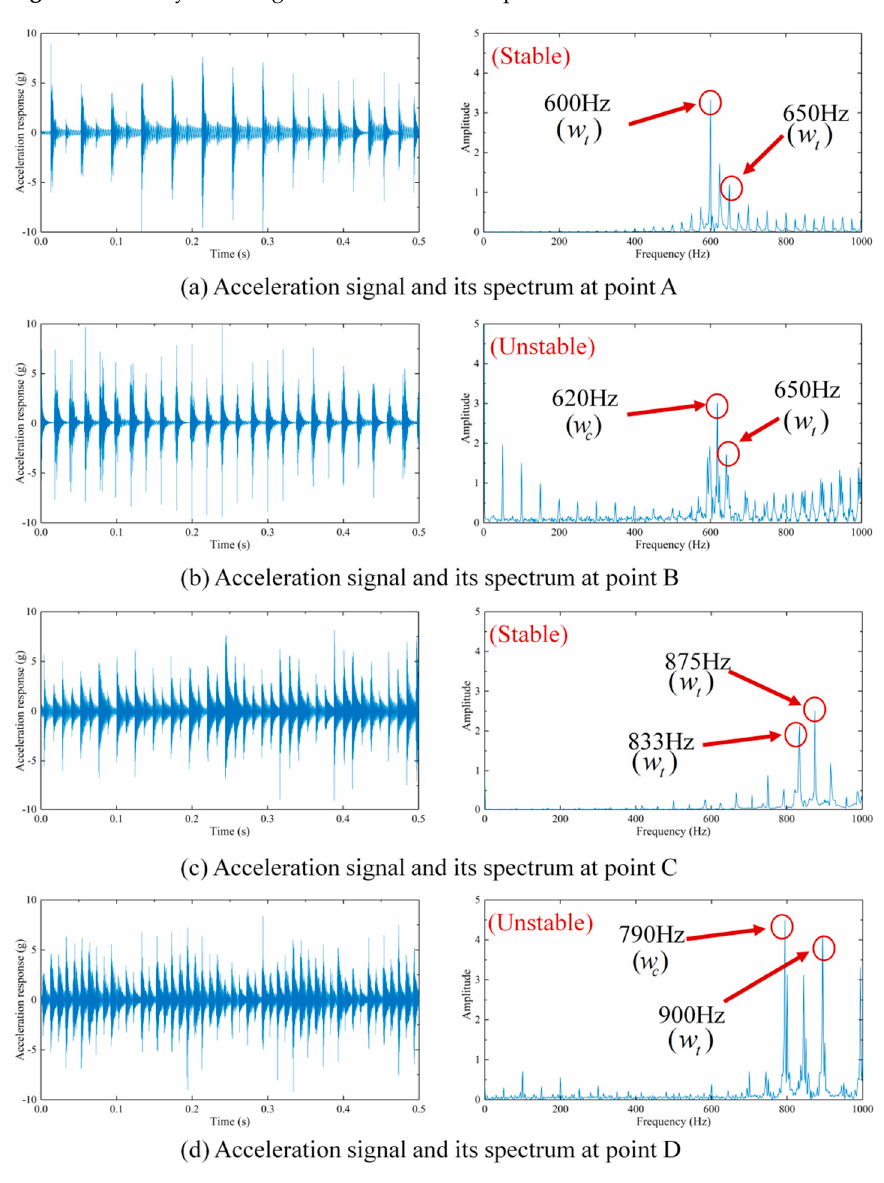
Figure 9. Acceleration signal and its spectrum at point A, B, C, and D in the milling of the thin-walled plate.